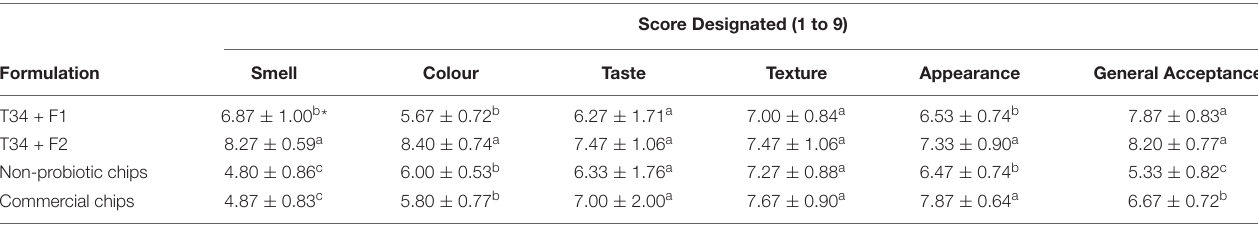
TABLE 6 | The sensory evaluation (smell, color, taste, texture, appearance, and general acceptance) of non-probiotic potato chips, commercial potato chips, and probiotic potato chips with different prepared formulations (Tarkhineh) during 120 days storage at 4 ◦ C. T34: Lactococcus lactis . F1: plain Tarkhineh. F2: turmeric Tarkhineh. Values shown are means ± standard deviations ( n =